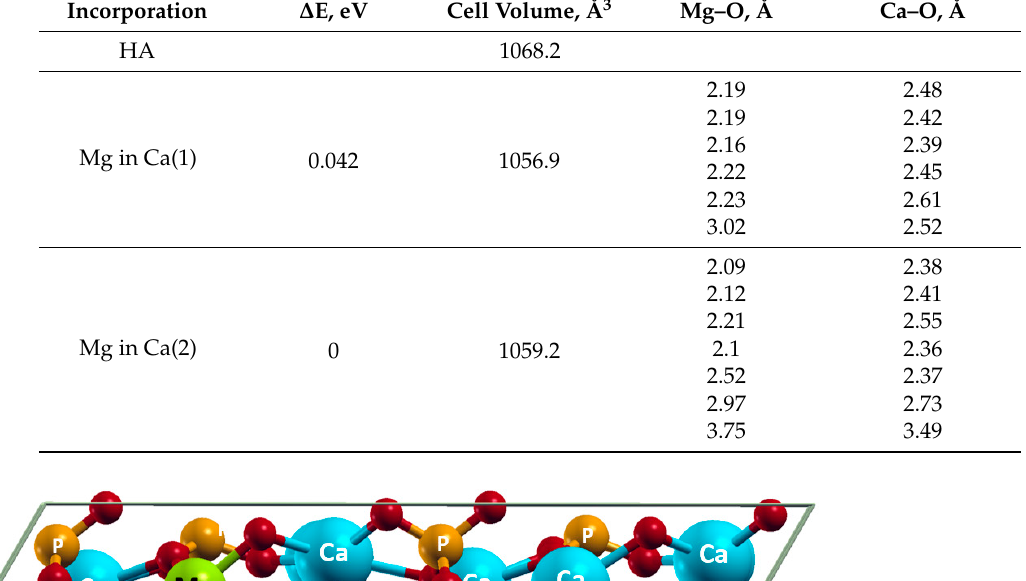
Table 1. Some parameters of the HA cell with formula Ca 10 (PO 4 ) 6 (OH) 2 and the cell with Mg 2+ incor- poration according to the formula Ca 9,5 Mg 0.5 (PO 4 ) 6 (OH) 2 . The relative Ca–O bonds in pure HA are